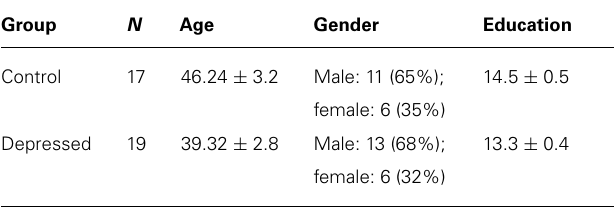
Table 1 |Table showing demographic information for the participants in this study. Group N Age Gender Education Control